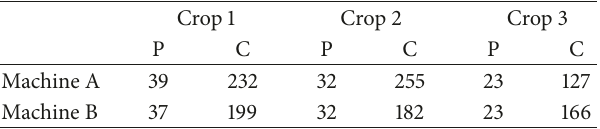
Table 1: Maintenance distribution preventive (P) and corrective (C) stops per crop.